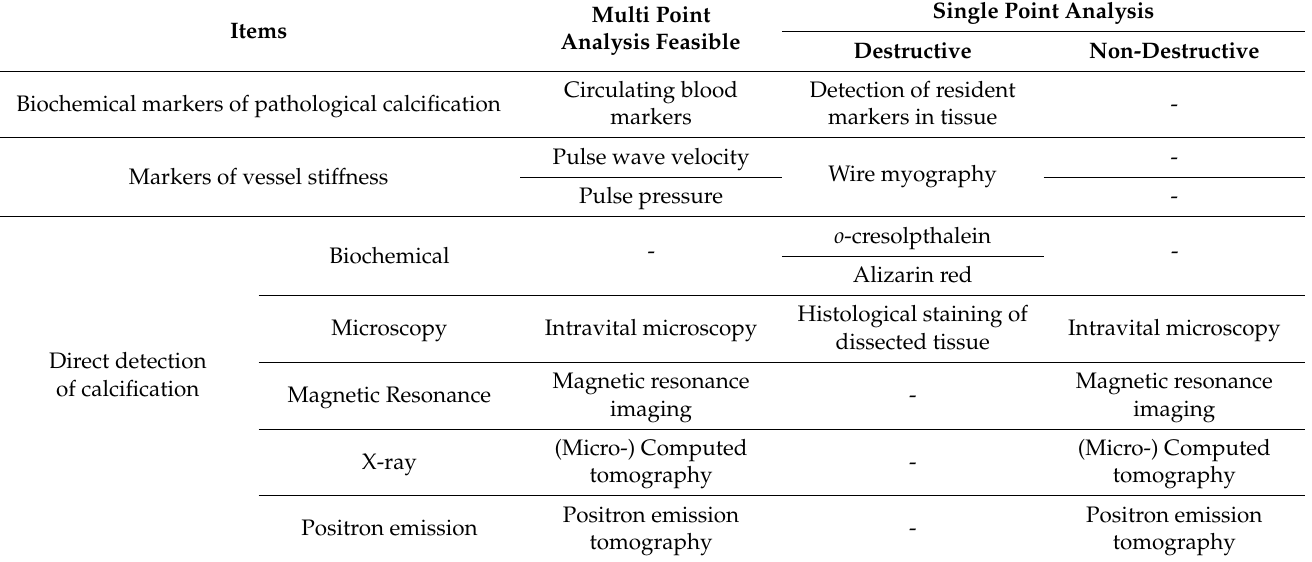
Table 2. Selected methods for the detection of vascular calcification in rodents. Methods where samples are subject to intense chemical or physical strain and/or sample restoration is not possible are rated as destructive methods. Methods which administer a light strain, or when sample restoration is possible, are termed non-destructive. Single Point Analysis Multi Point Items Analysis Feasible Biochemical markers of pathological calcification Markers of vessel stiffness